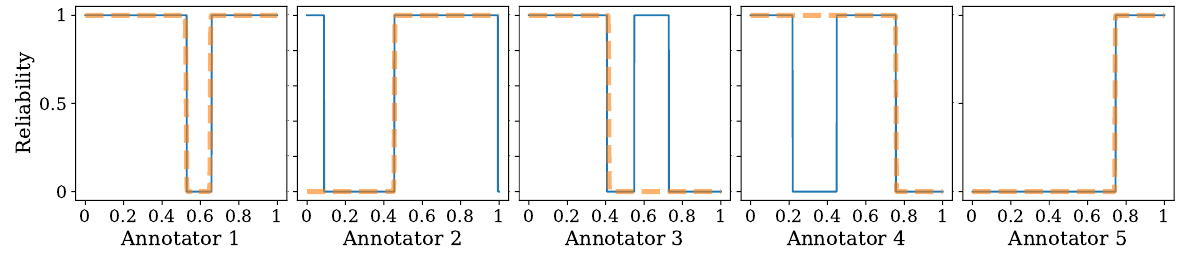
Figure 5. GCECDL-based annotators’ performance (reliability) estimation for the synthetic 1D experiment. Orange dashed line depicts (from left to right) the simulated accuracy for each annotator based on Equations (19)–(22). The blue line shows (from left to right) the estimated annotator’s reliability ( λ r